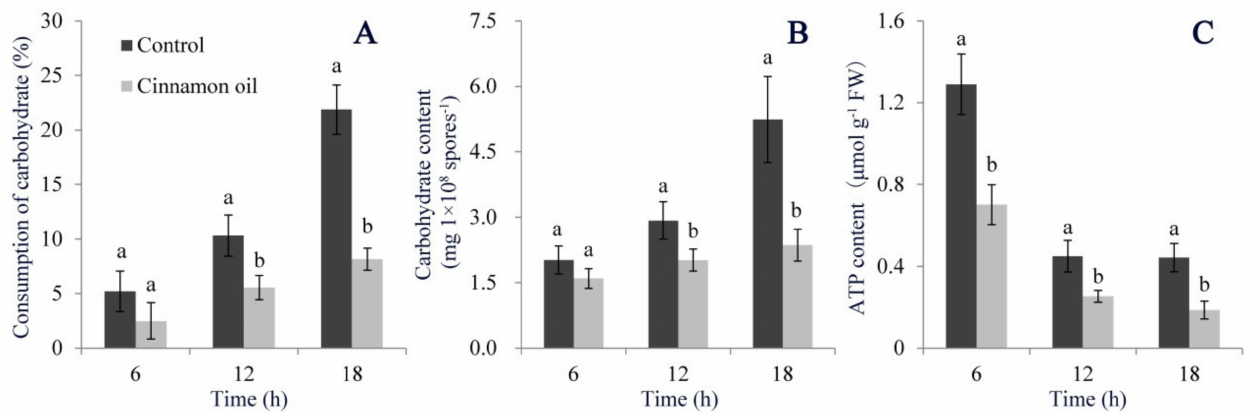
Figure 7. Effects of 0.25 mg L − 1 cinnamon oil on carbohydrate consumption in potato dextrose broth (PDB) ( A ), intracellular carbohydrate production ( B ), and intracellular ATP content ( C ). Bar represents the standard deviation of the means of three independent experiments. Lower-case letters indicate significant differences at p < 0.05 at each time